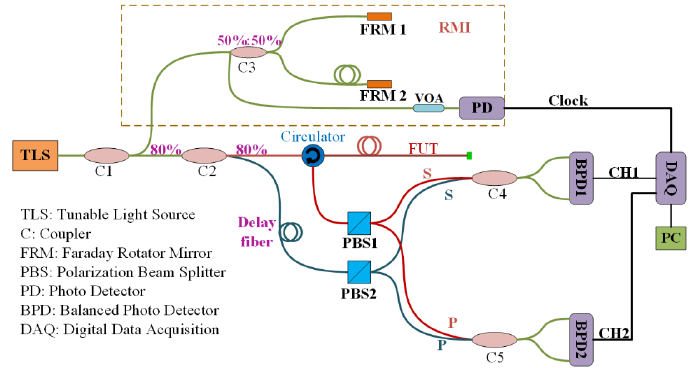
Figure 1. Schematic illustration of the OFDR sensing system.